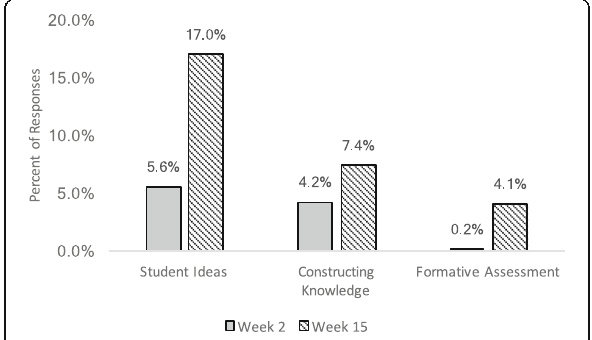
Fig. 3 Averaged overall major codes. The percentage of responses that were coded as student ideas , constructing knowledge , and formative assessment and averaged across five semesters. Week 2 responses are shown in solid gray, while week 15 responses are indicated by the striped